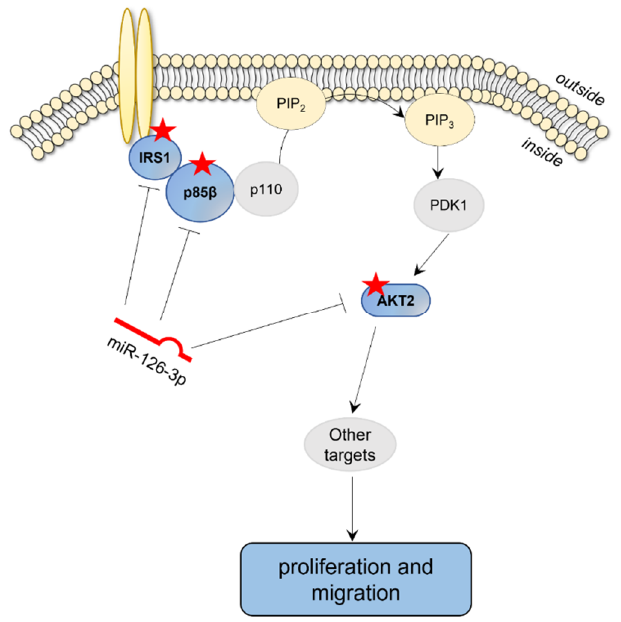
Figure 8. Schematic representation of miR-126-3p regulation of PI3K/AKT signaling and effects on BC cells. Red stars: miR-126-3p direct